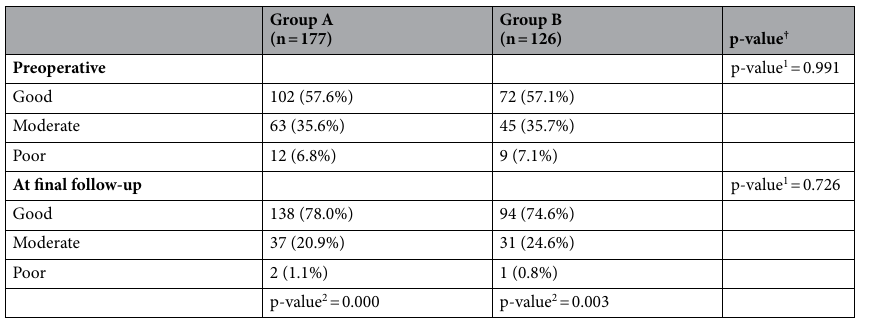
Table 3. Titmus stereotest results in groups A and Band clinical variables. Group A = alignment between 10 prism dioptres (PD) exodeviation and 5 PD esodeviation at the last follow-up; Group B = residual or recurrent